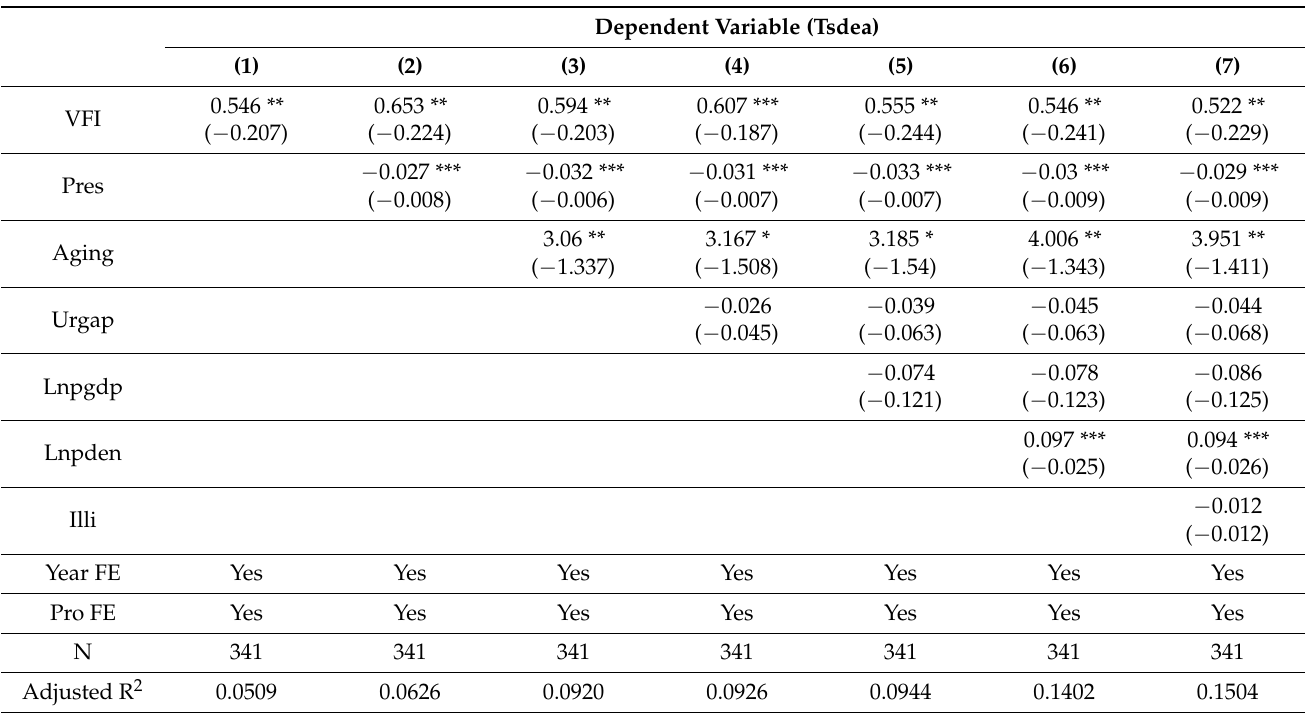
Table 3. Empirical results of the impact of vertical fiscal imbalance on fiscal health expenditure efficiency in